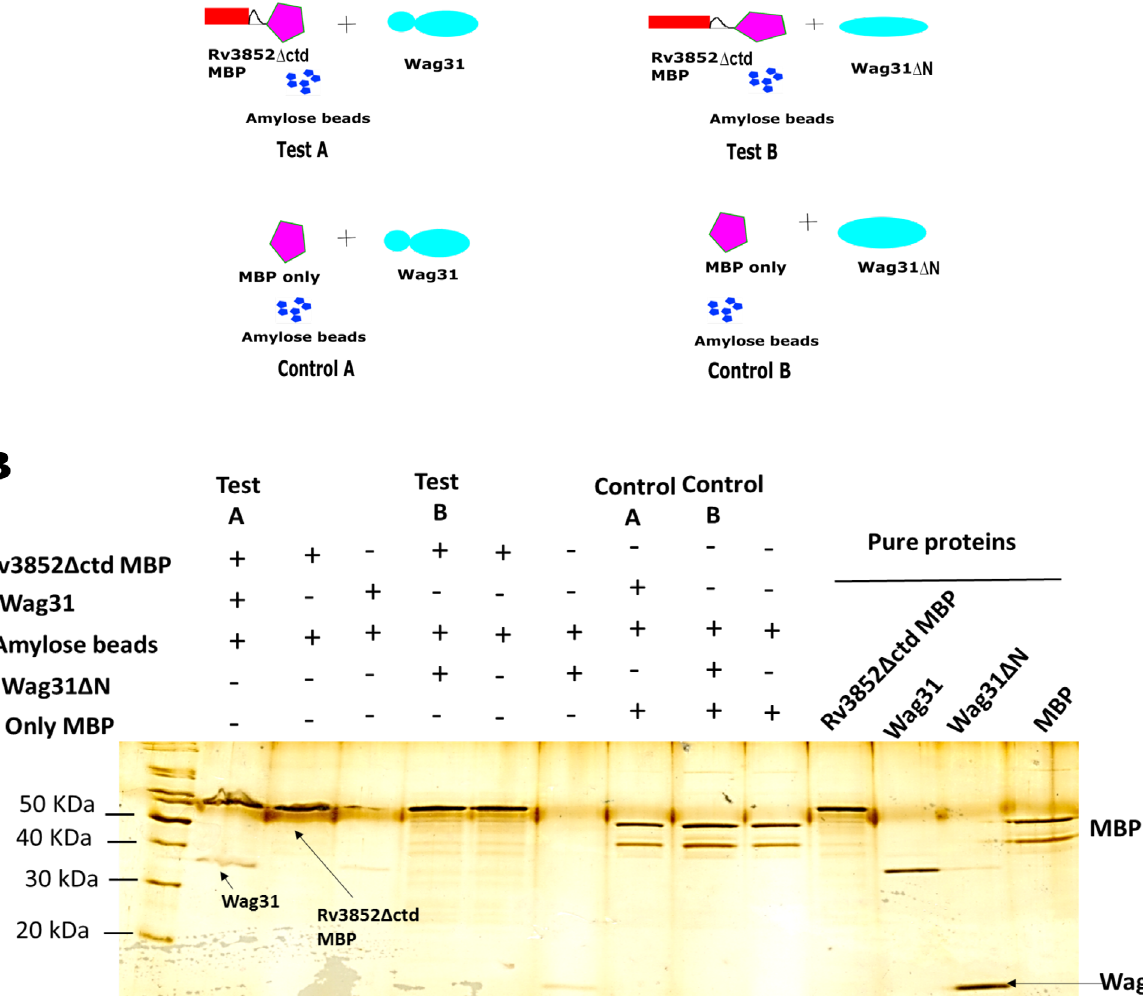
Figure 3. Rv3852∆ctd interacts with N-terminal region of Wag31. The co-immunoprecipitation reactions using amylose beads were carried out as indicated in (A) . The test reactions A and B contain Rv3852∆ctd -MBP with Wag31 and Rv3852∆ctd - MBP with Wag31∆ N, respectively. The control pairs A and B show negative control reactions containing only MBP with Wag31 and Wag31∆ N, respectively. ( B ) The silver-stained SDS-PAGE depicts the precipitated protein elutes from the test and control reactions, set up as indicated in ( A ). The reaction contents are shown on top of each lane of the gel. The position of proteins is shown by arrow marks. Pure proteins are shown as indicated in the last four